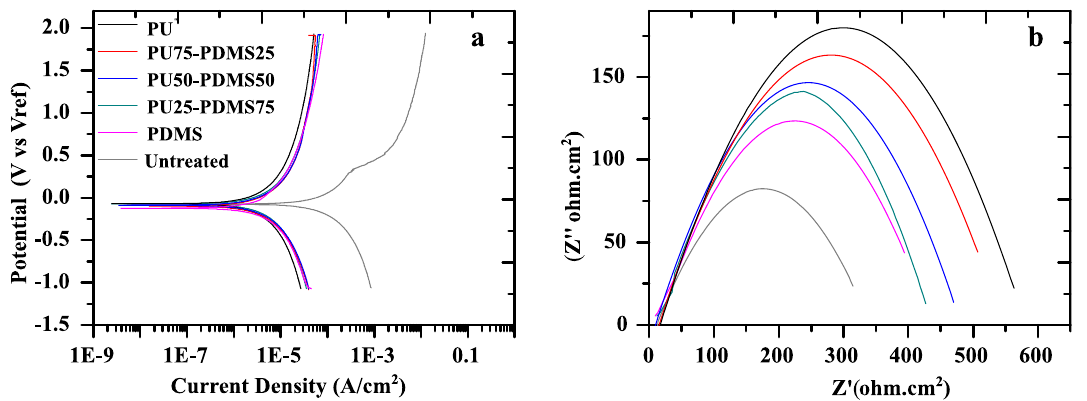
Figure 8: Potentiodynamic scans and Nyquist plots for AISI 316L coated with PU – PDMS polymers in Ringer ’ s solution: ( a ) potentiodynamic and ( b )